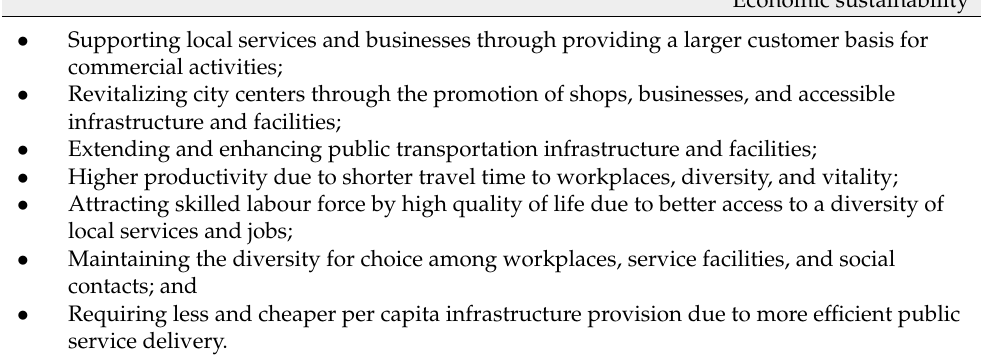
Table 1. The multidimensional benefits of proximity for sustainability. Adapted from Bibri [60].